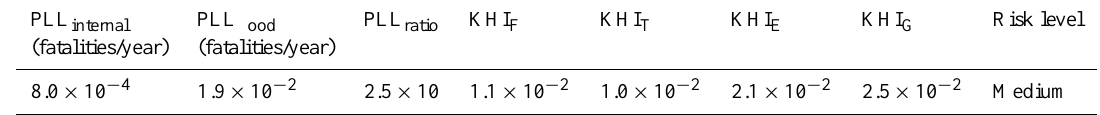
Table 6. Risk indexes obtained from QRA (PLLs [28]) and from the presented methodology (KHIs) for case study 1.